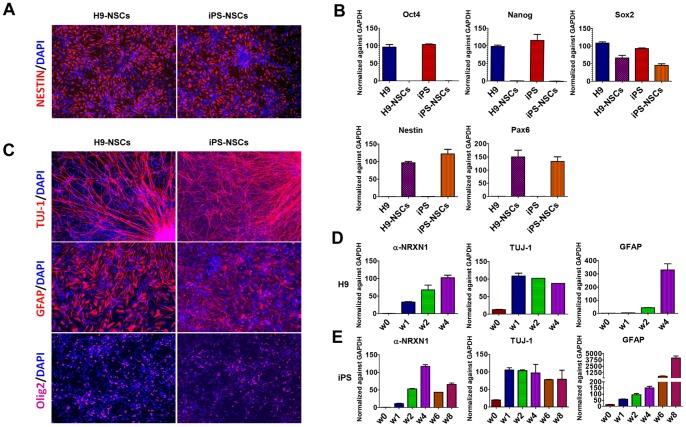
Neural stem cells (NSCs) derived from human embryonic stem cells H9 and hiPS maintain differentiation potential.
A. NESTIN staining indicates that close to 100% positive NSCs are derived from H9 and hiPS. B. qPCR showed that hESCs (H9) and iPS highly express pluripotency markers Oct4, Nanog and Sox2, yet NSCs highly express NSCs markers Pax6 and Nestin. C. H9 and hiPS derived NSCs can differentiate into both neural and glial lineage as stained by neuron marker TUJ-1, astrocyte marker GFAP and oligodendrocyte marker Olig2. D. H9 and E. iPS derived NSCs differentiated in time-dependent manner, with predicated gene expression pattern. w, abbr. of week.